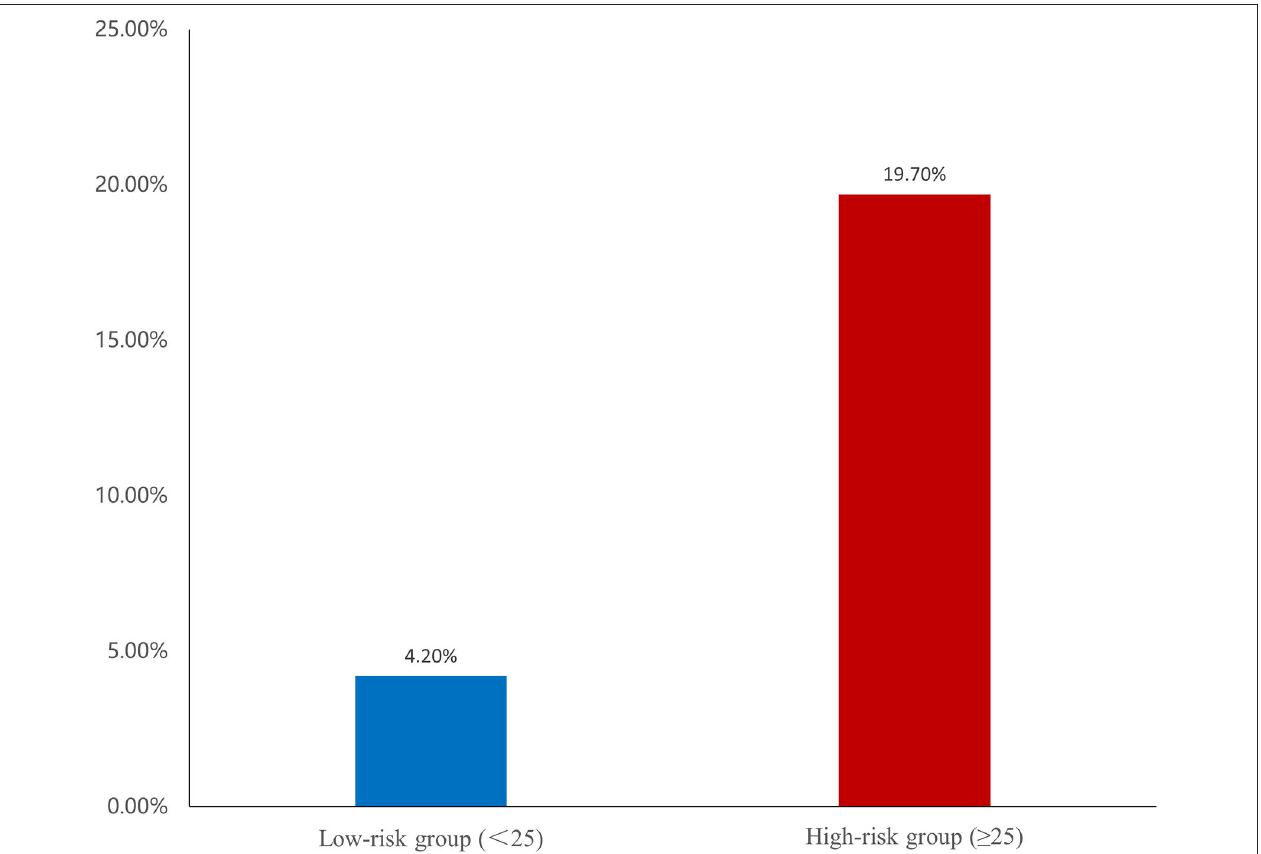
FIGURE 3 | Risk of ventricular tachycardia/ventricular fibrillation (VT/VF) among two groups. The risk classes were categorized based on the cut-off value of FSS caFFR .